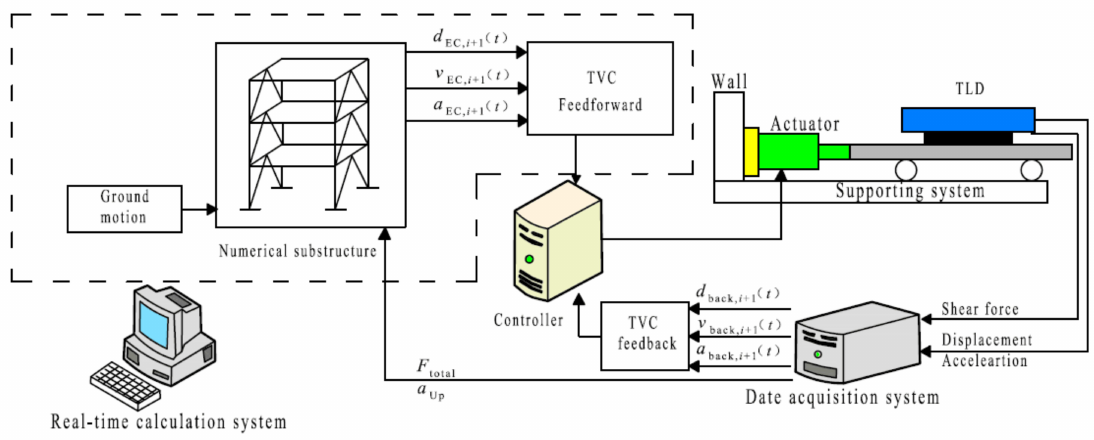
Figure 5. Block diagram of shaking table substructure testing (STST) for three-story frame structure with a tuned liquid damper